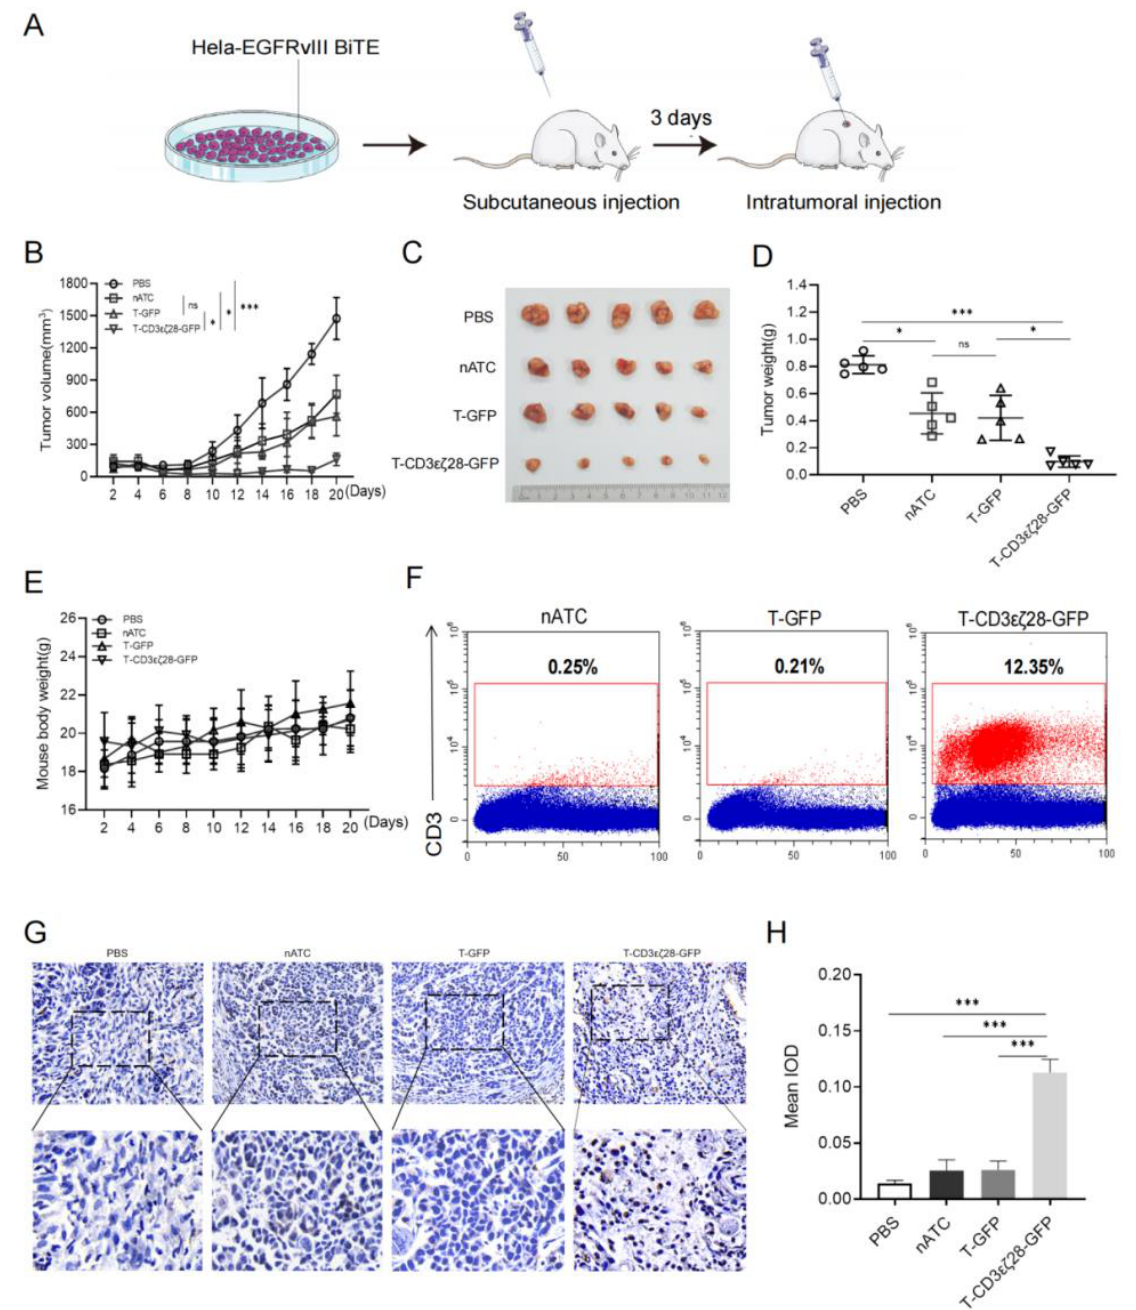
Figure 3. T-CD3 εζ 28-GFP had enhanced antitumor activity in the xenograft tumor Figure 3. T- CD3εζ28 -GFP had enhanced antitumor activity in the xenograft tumor model. ( A ) Sche- matic diagram of an HeLa-EGFR vIII BiTE tumor model treated with T cells. Nude mice were sub- cutaneously injected HeLa-EGFR vIII BiTE cells (5 × 10 6 tumor cells per animal in 100 μL PBS) on day 0. Control 1 × PBS and nATC, T-GFP, T- CD3εζ28 -GFP cells (1 × 10 7 cells per animal in 100 μL PBS) were intra-tumorally injected into mice on day 3. ( B )The tumor growth curves of different group are displayed. After T cells was injected, the tumor sizes were measured with calipers every two days, and tumor volumes (in mm 3 ) were determined using the formula W 2 * L/2, where W and L represents tumor width and tumor length, respectively. ( C , D ) Comparison of tumor sizes and